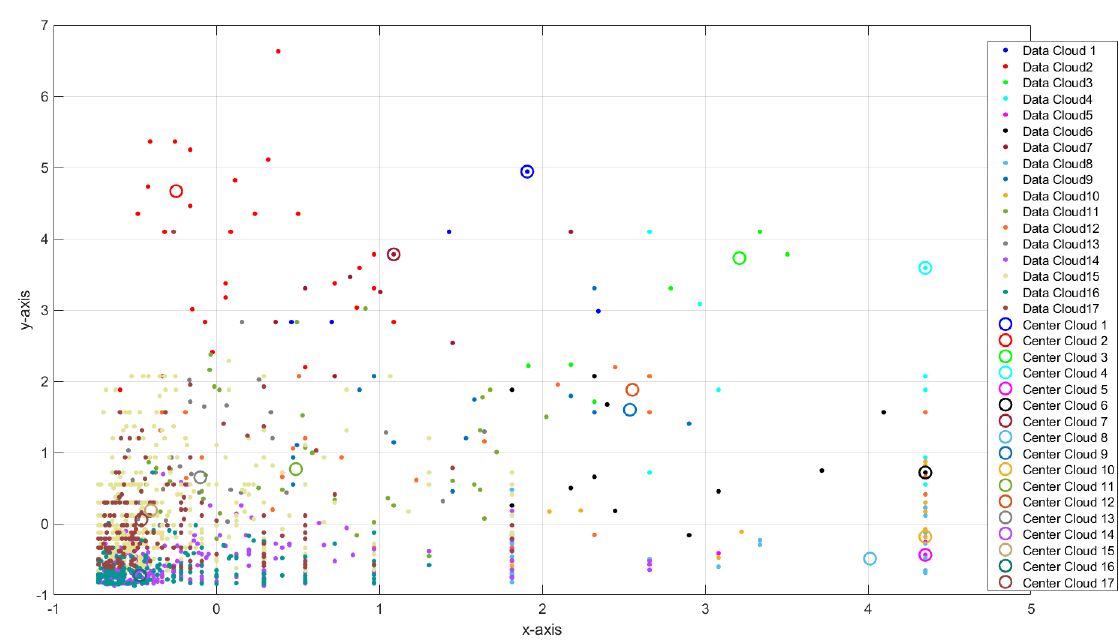
Figure 4. Example of the SODA approach with 17